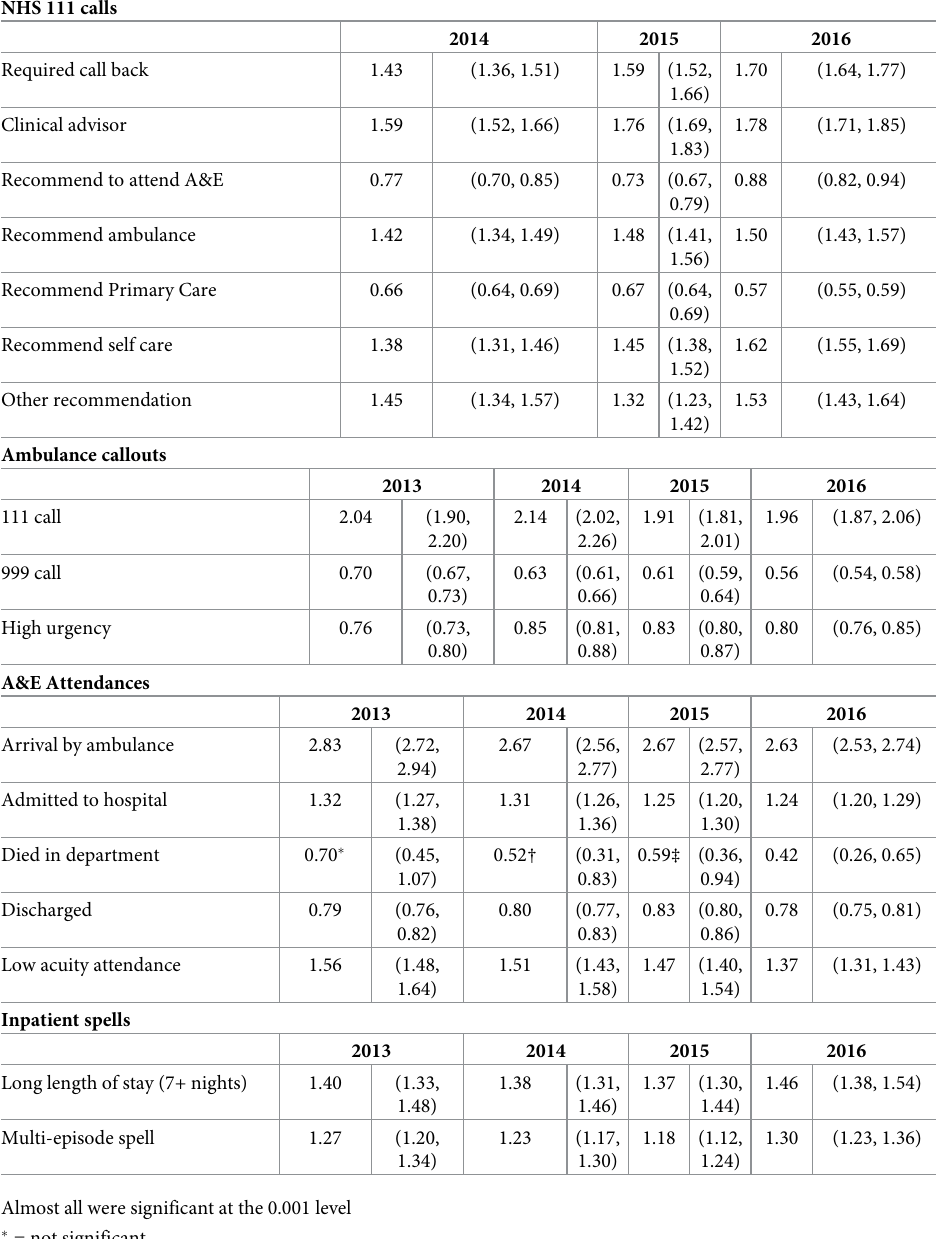
Table 4. Adjusted odds ratios (95% confidence intervals) for key features of UEC service use, comparing UMHS cohort and UEC-only group